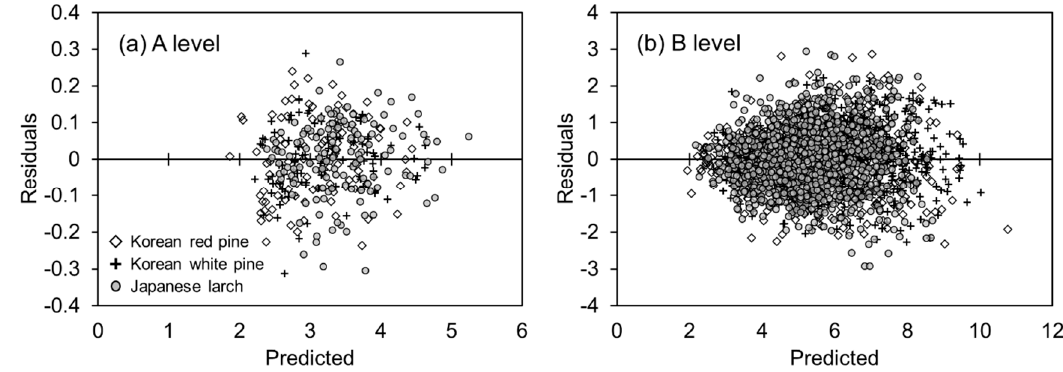
Figure 2. Residual plots of allometric models for ( a ) A-level and ( b ) B-level stocking by species. The residuals are derived from the model fitting of Equations (8) and (9) in Table 2.